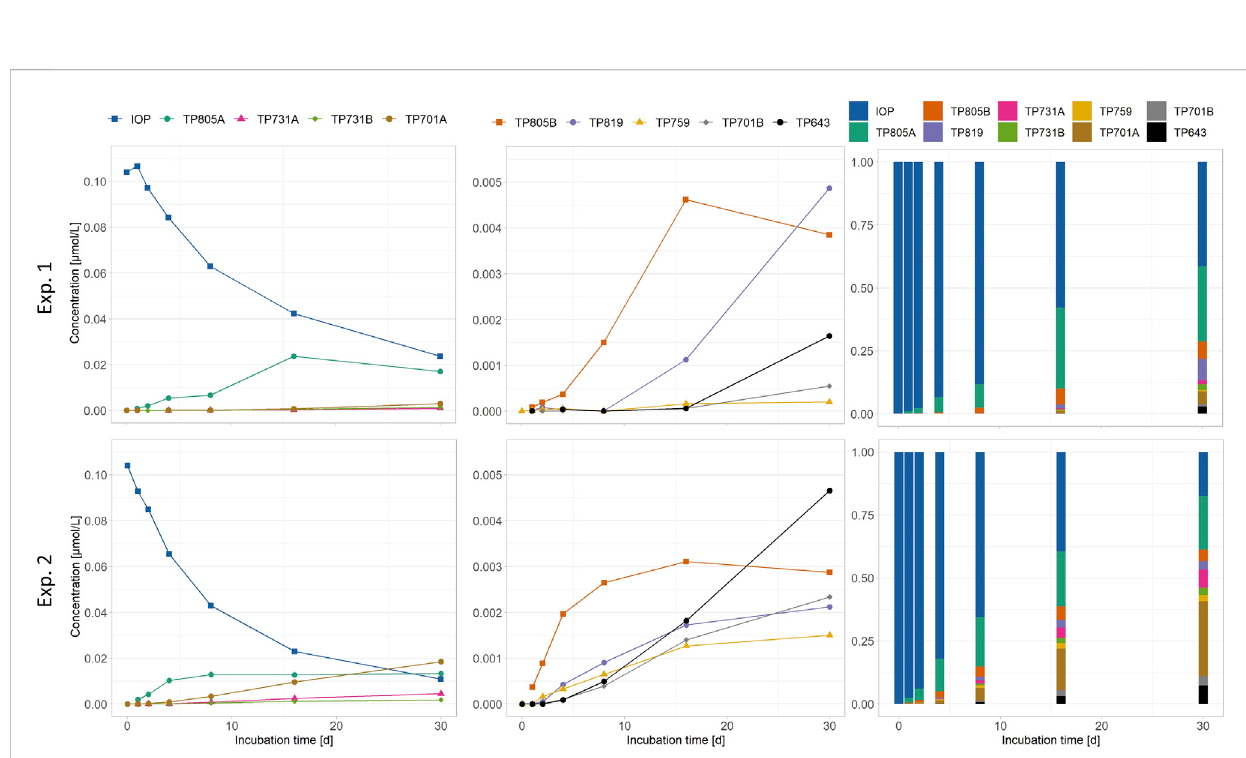
FIGURE 6 Concentrations of iopromide (IOP) and transformation products (TPs) formed during exposure to periphyton experiment (Exp.) 1 and mussels with periphyton (Exp.2).ForExp. 1,onereplicateandfor Exp.2, themeanoftworeplicatesisshown. Thetransformation products weresemi-quanti fi edusing the calibration equation of IOP (for details, see 2.4.2). Note the different scales of the y